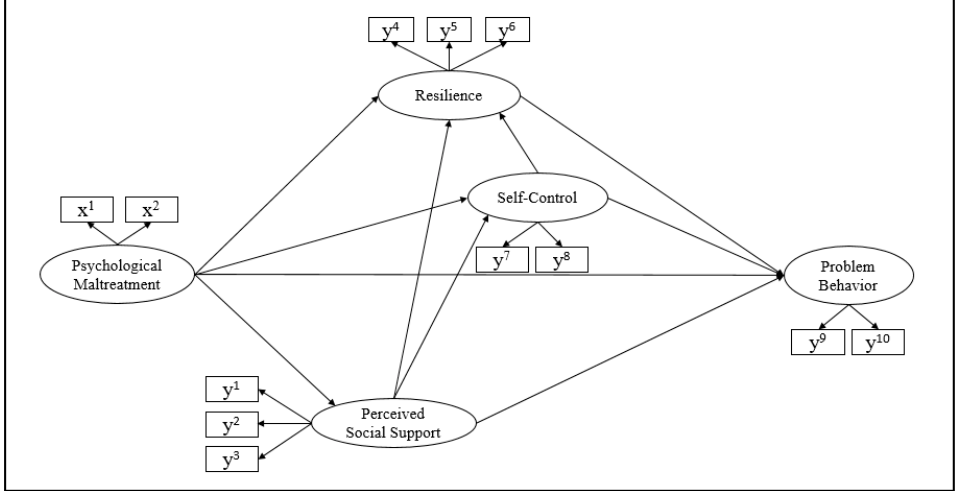
Figure 1. Hypothetical Model of Problem Behavior among Adolescents. x 1 , emotional abuse; x 2 , neglect; y 1 , family; y 2 , friend; y 3 , teacher; y 4 , affirmative; y 5 , controllability; y 6 , sociability; y 7 , long-term control; y 8 , short-term control; y 9 , internalizing; y 10 , externalizing.